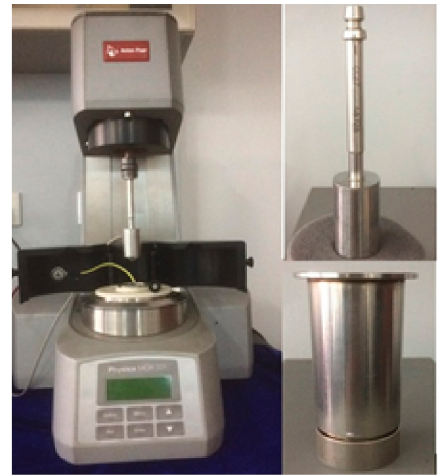
Figure 4: Rheometer.